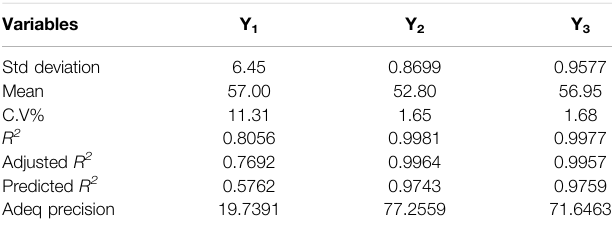
TABLE 3 | Fit statistics data analysis for the effect of selected variables on the responses. Variables